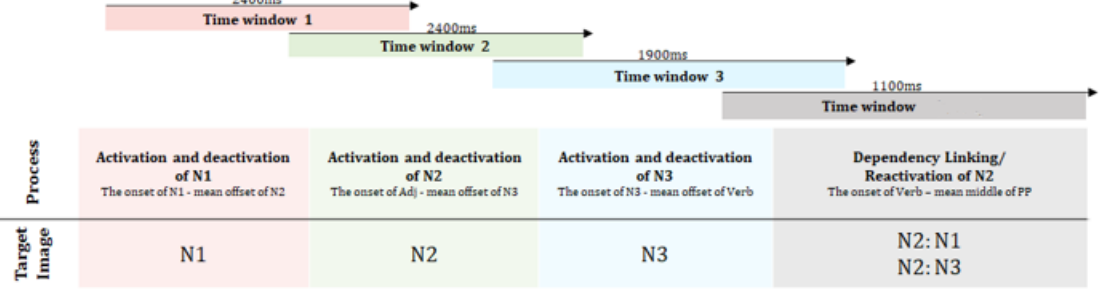
Figure 3. Specified windows of interest. The arrows represent when in the sentence a prespecified window starts and ends. The windows of analysis were overlapping as we wanted to capture the full morphology of the gaze pattern toward a targeted image. In these windows, we capture the activation (gazes toward) and deactivation (gazes away) parts of lexical processing. Here, we divided our sentence into four analysis windows to capture processing patterns via the gaze dynamics to the three images of the nouns that were mentioned in the sentence (here N1 represents the illustration of eagle, N2 the snake, N3 the bear).